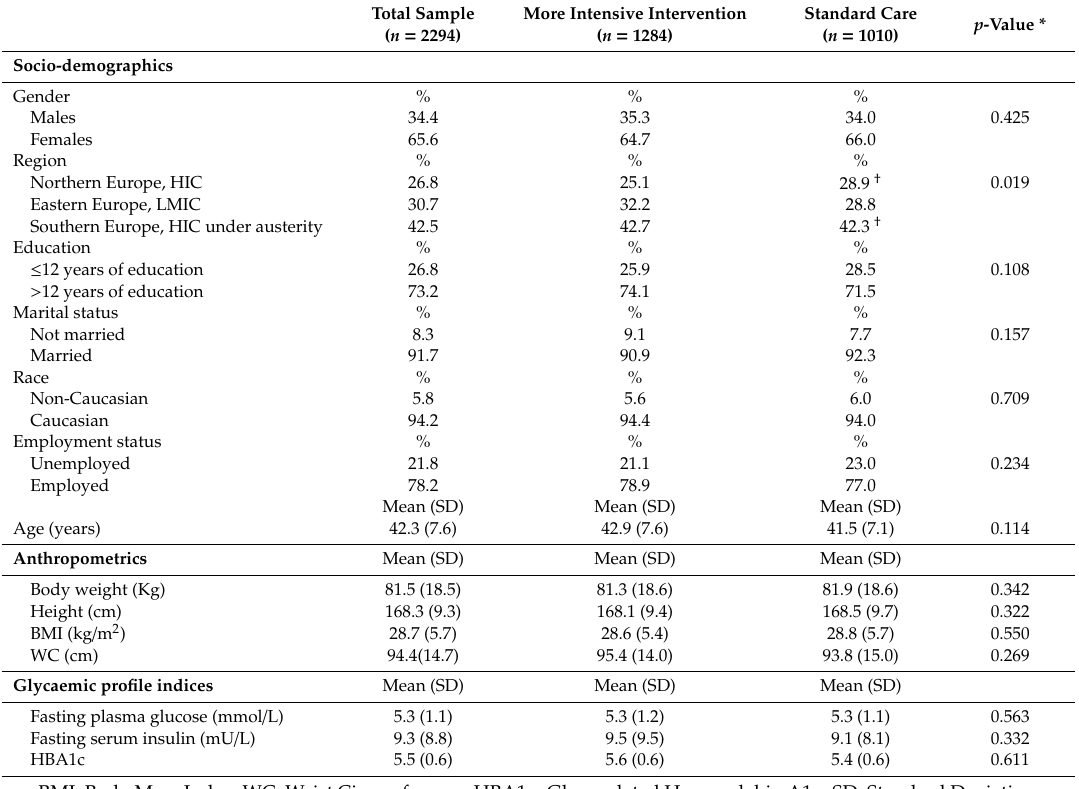
Table 1. Descriptive characteristics of the study